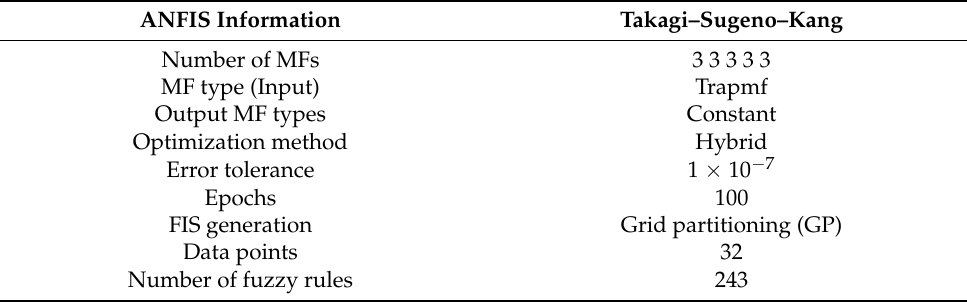
Table 5. Details of the ANFIS model used in this